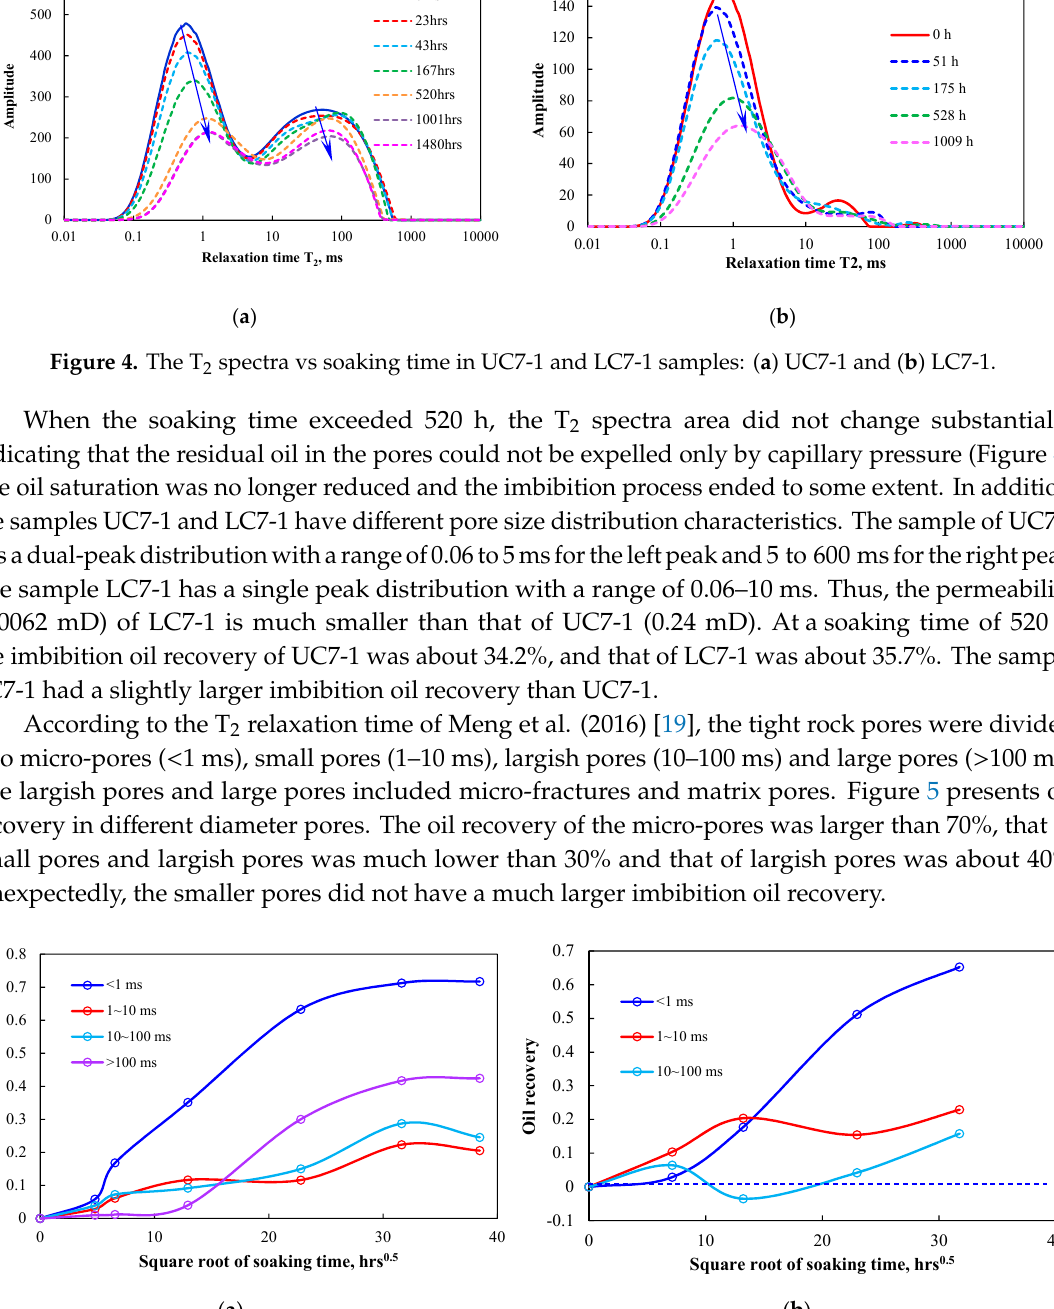
Figure 5. Oil recovery in different diameter pores: ( a ) UC7-1 and ( b ) LC7-1.